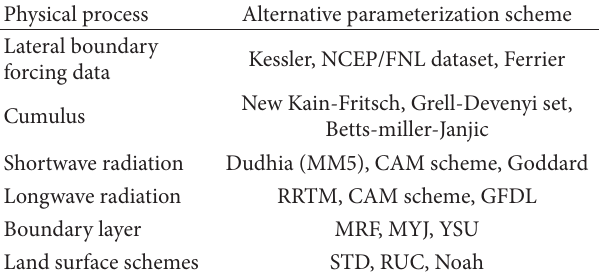
Table 1: Physical process and parameterization